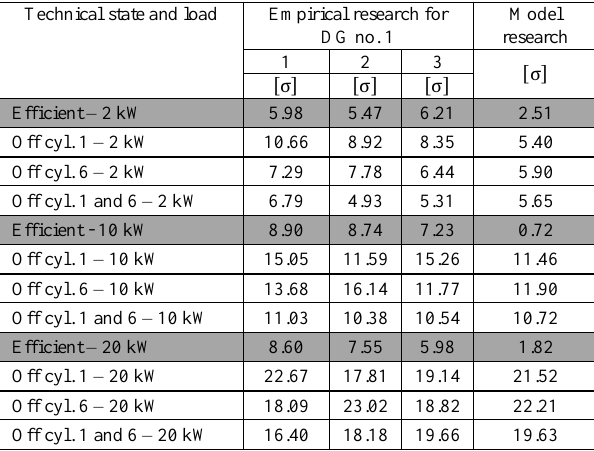
Table 3. List of values of standard deviations for various technical states of Technical state and load Empirical research for